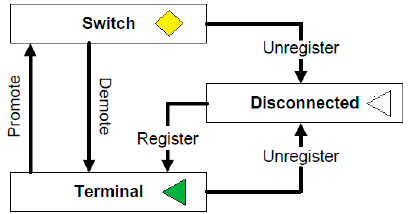
Figure 1. Different states of the SNs in PRIME. The SN representation varies according its role: yellow diamond for switch , green triangle for terminal and empty triangle for disconnected.